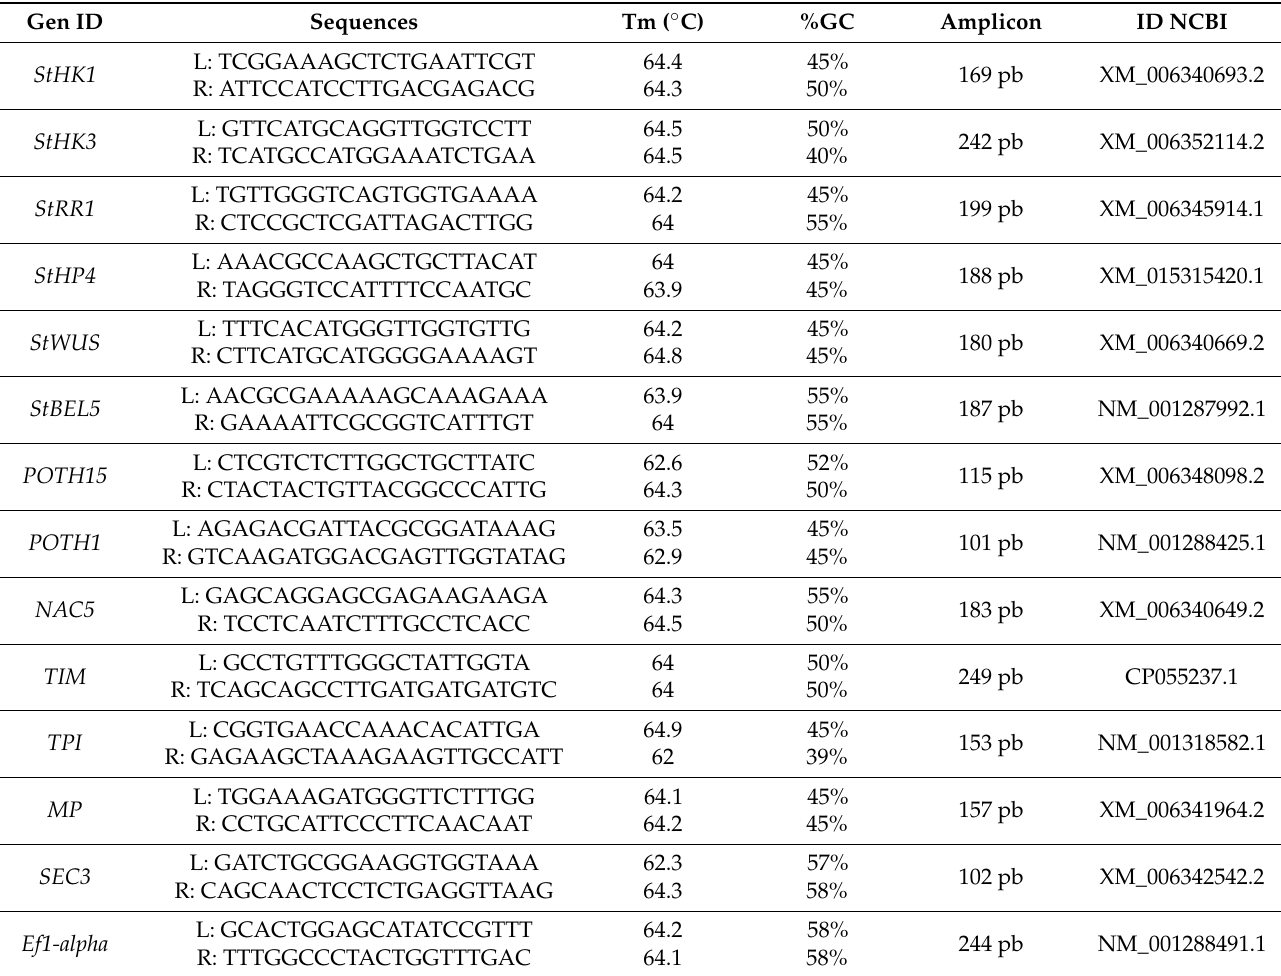
Table 1. Primer design of genes that were analyzed during microtuber induction of potato S. tuberosum cv. Alpha. Gen